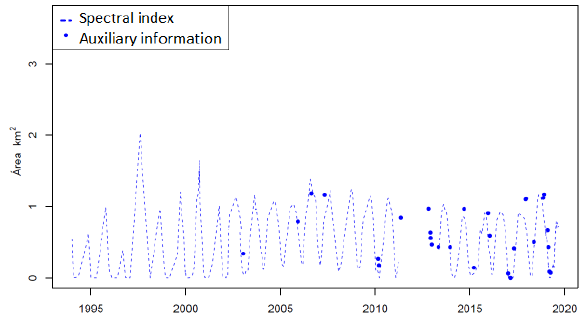
Figure 4. Wetland, Isluga Volcano National Park.